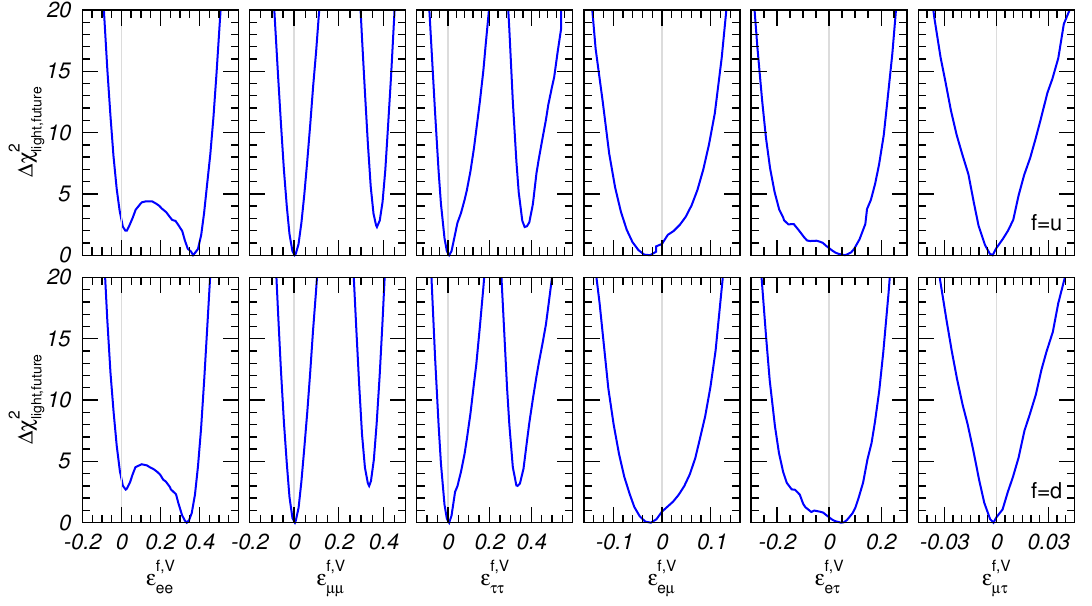
Figure 6 . Dependence of (cid:1) (cid:31) 2 on the NSI parameters (cid:15) f;V for f = u (upper panels) and light,future (cid:11)(cid:12) f = d (lower panels), using current global data on oscillations combined with arti(cid:12)cial COHERENT data generated for all (cid:15) (cid:11)(cid:12) set to zero.